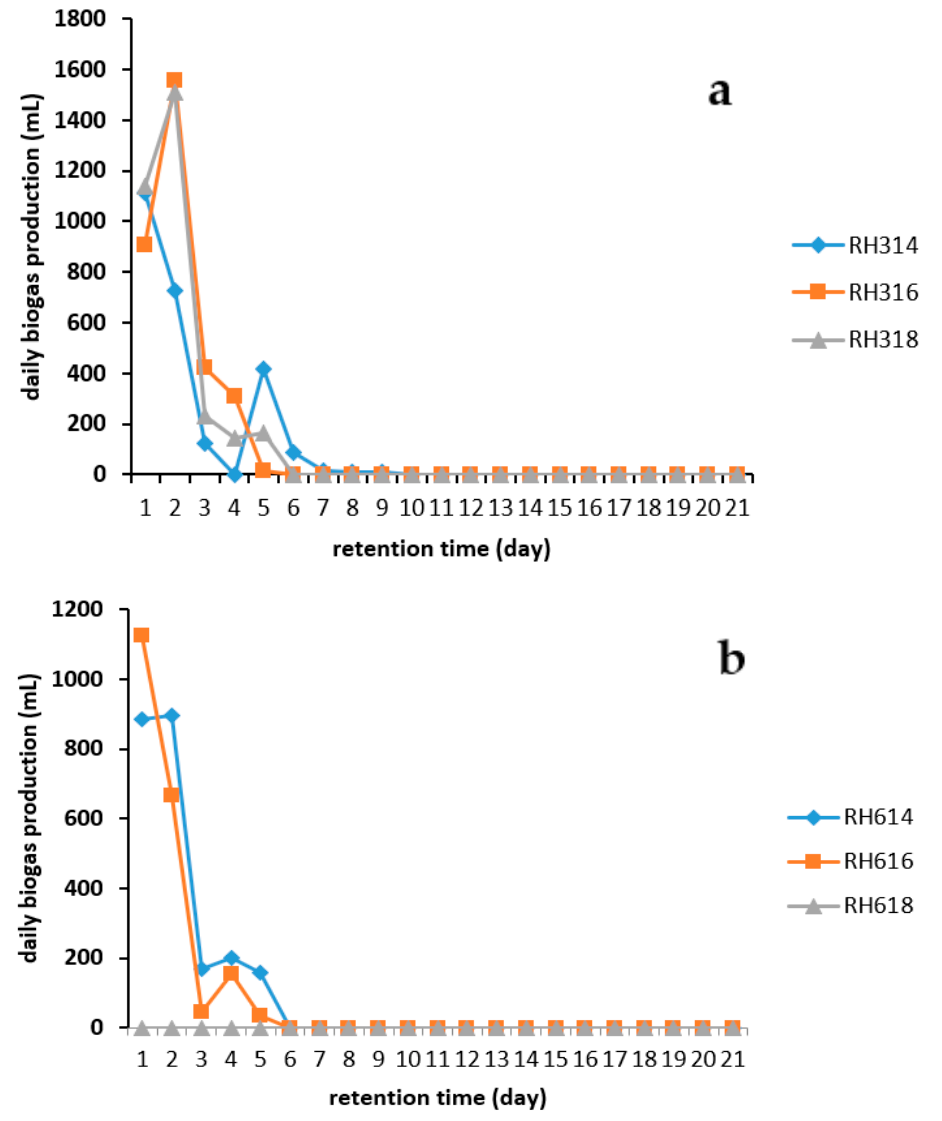
Figure 3. Daily biogas production from RH for two particle sizes: ( a ) 300 and ( b ) 600 μ m.